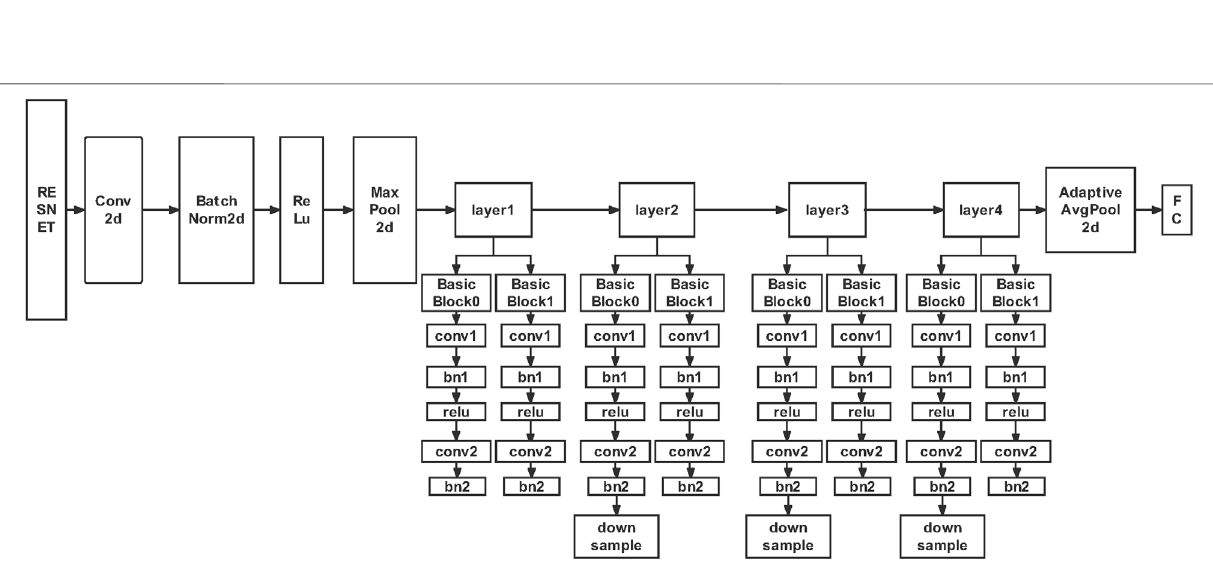
Frontiers in Genetics |